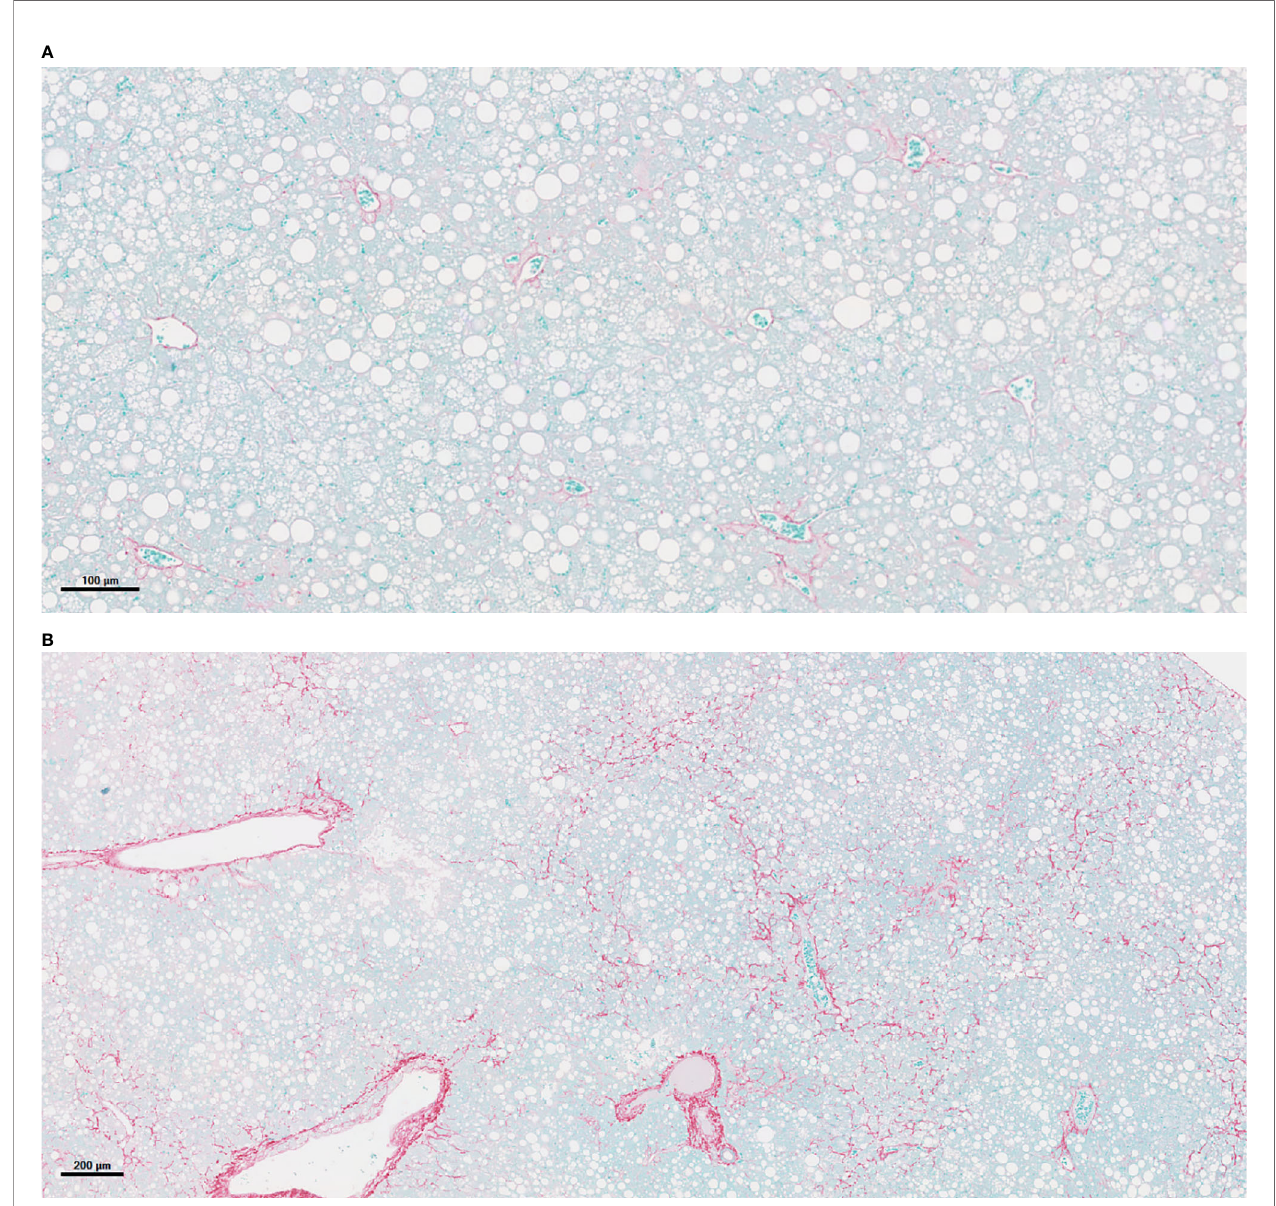
FIGURE 3 | PNPLA3 I148M -associated acceleration of NASH and fi brosis. (A) Liver histology in mouse of empty vector (Luc) after 16 weeks on a Western diet/sugar water (WDSW) diet with NAFLD with minimal fi brosis. (B) Hepatocyte of mouse with PNPLA3 I148M after 16 weeks on a WDSW diet demonstrating NAFLD with advanced bridging fi brosis. (A) 16wks AAV LUC (10x) (B) 16wks PNPLA3 I148M